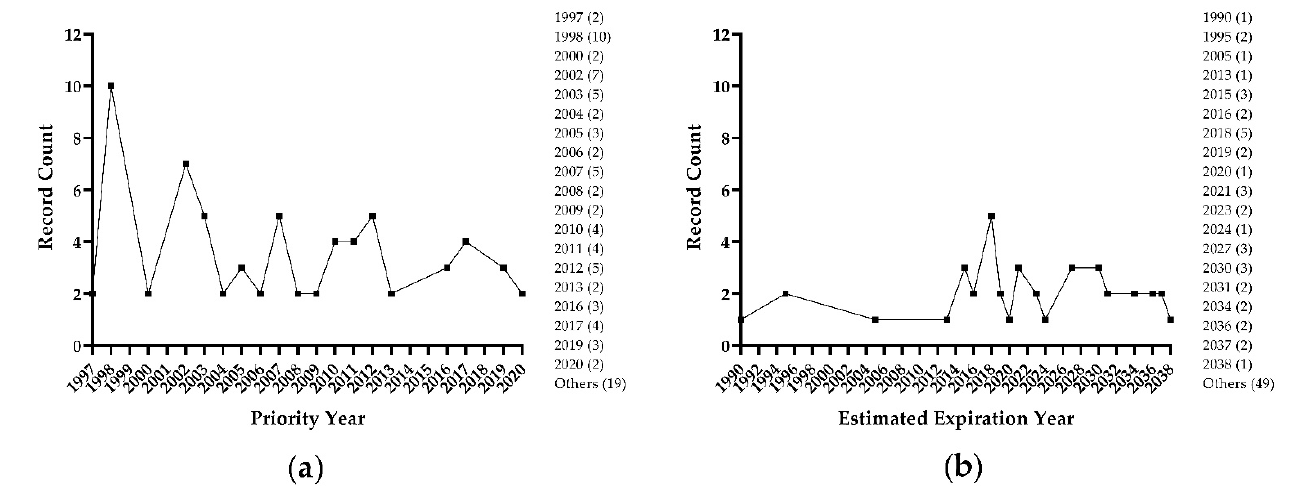
Figure 1. Temporal analysis of patent documents. ( a ) Earliest priority year; ( b ) estimated expiration year.